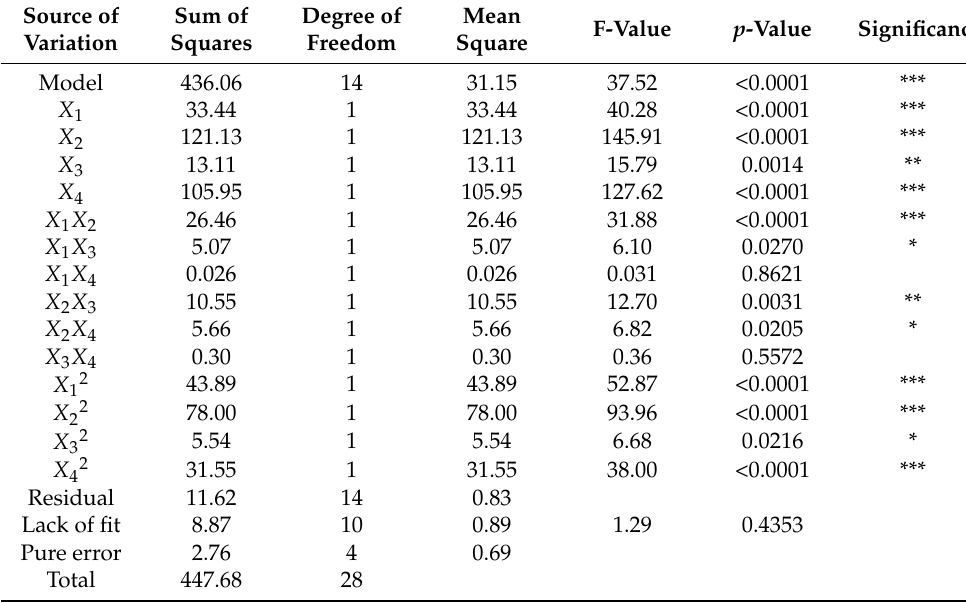
Mean F-Value p -Value Significance Square